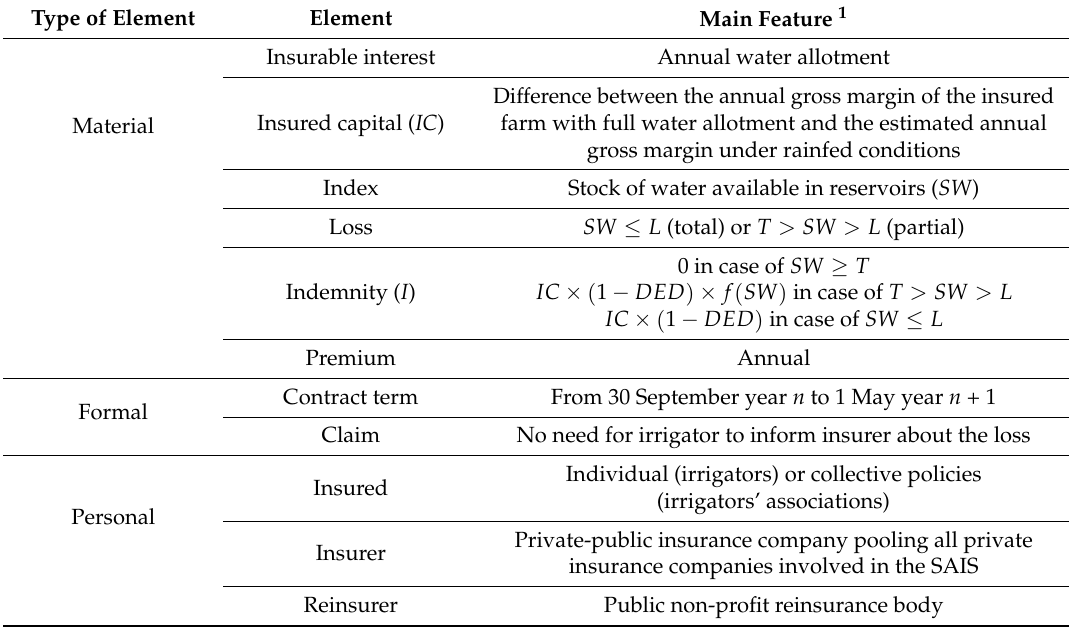
Table 2. Main features of the proposed hydrological drought index-based insurance in